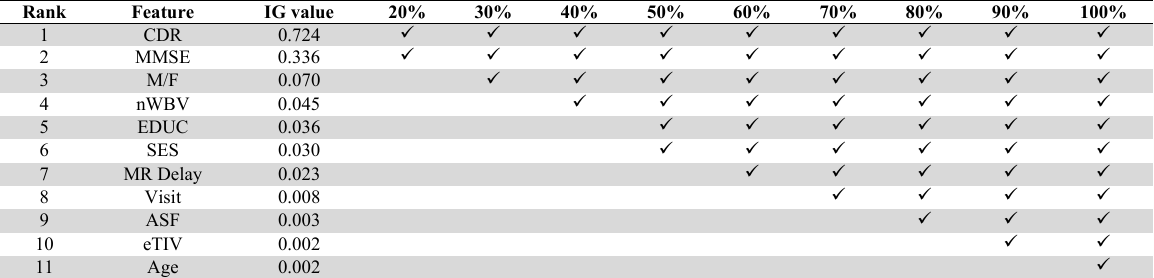
Tables 3 to 7 show the aggregate evaluation results for all labels using different selection thresholds of top predictive features. The values in the bold represent the most predictive models for each feature set that are selected by a threshold. Table 3 shows the results of all machine learning models in terms of the AUC measure. It can be observed that no one model can perform better than other models. Remarkably, both DT and NB can show somehow more accurate results than other models. This has also been confirmed by the results in Figure 5 that shows values of AUC for each machine learning model across different threshold values. DT and NB show stable accuracy which suggests that the changes in AUC across different thresholds. Although SVM can use different kernel functions to map data from low dimension to higher, it does not work efficiently for this complex structure dataset because it contains numerical and categorical data. All used models are supposed to support the nonlinear relationship between variables, but since SVM cannot treat input categorical variables in its implementation, only numeric input variables were used. This may explain why SVM could not surpass other prediction models. Surprisingly, the RF obtained less accurate results, even though that RF can treat both numerical and categorical variables and built upon the idea of ensemble learning. Results of AUC evaluation measure against different feature sets %of selected features by Information Gain Model